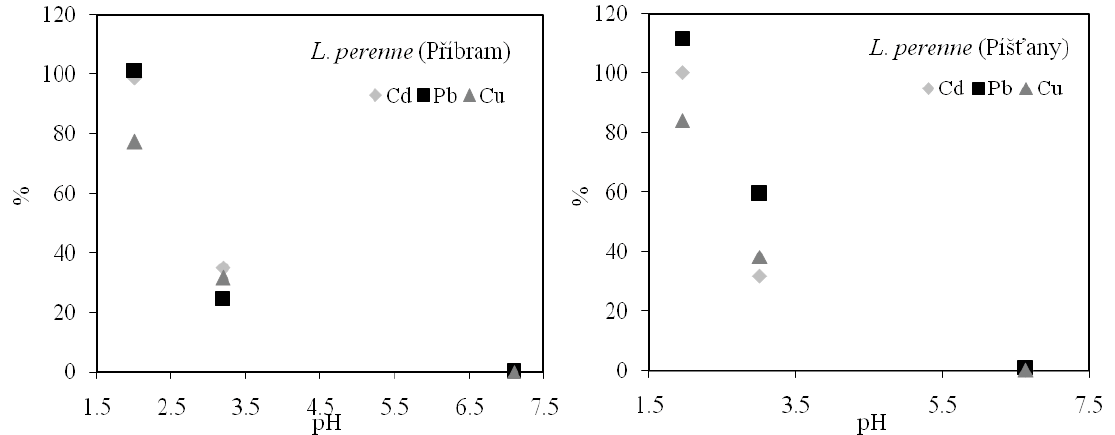
Figure 5. Dependence of ionic portion (in %) measured by DP-ASV on pH of Lolium perenne L. soil solution growth on both localities. The total contents of metals were measured by ET-AAS and amount to 100%.